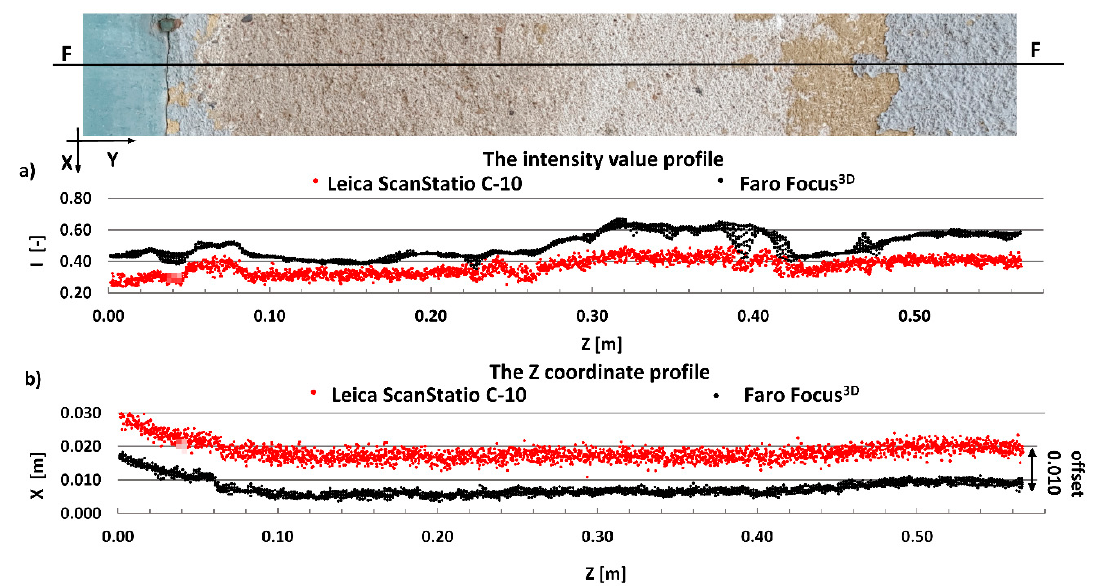
Figure 8. EE profiles—brick wall with damaged plaster, ( a ) intensity data profile, and ( b ) geometric data profile.